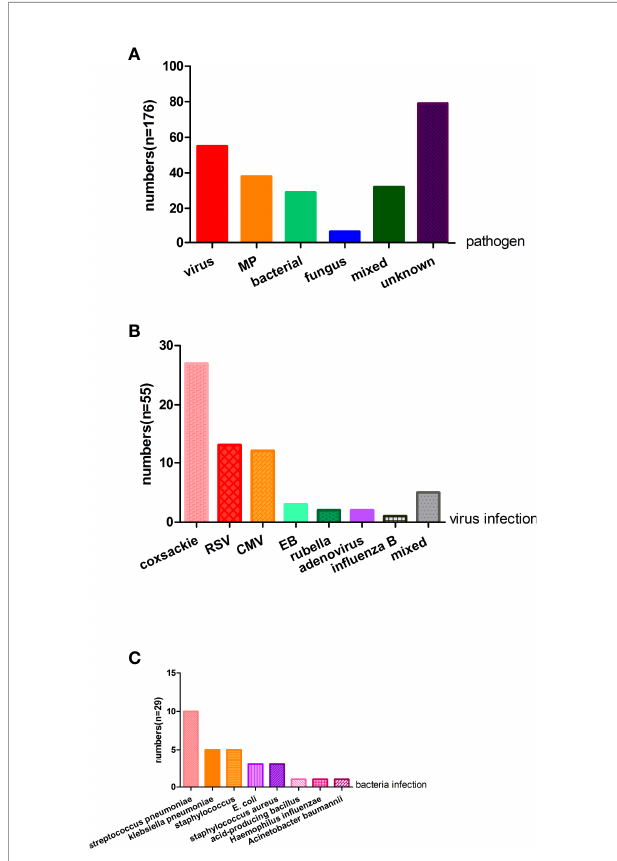
FIGURE 2 | The pathogen analysis of the wheezing children (A) For 176 patients, virus, MP, bacterial, fungus, and mixed are causes of wheezing, but nearly half of the children ’ s etiology were unknown. (B) Fifty- fi ve patients were infected with a virus and the top three virus were coxsackie virus, RSV, and CMV. (C) Twenty-nine patients were infected with bacteria and common bacteria were streptococcus pneumoniae, klebsiella pneumoniae, staphylococcus, and E.coli. MP, mycoplasma pneumoniae; RSV, respiratory syncytial virus; CMV, cytomegalovirus; E.coli, Escherichia coli.